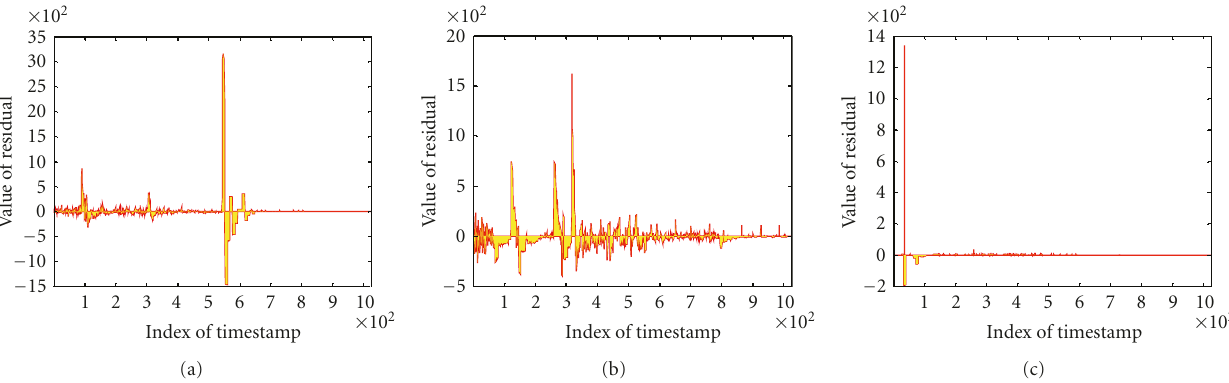
Figure 5: Residuals for number of flows per minute; from left to right is Figures 5(a), 5(b), and 5(c) representing TCP, UDP, and ICMP flows,